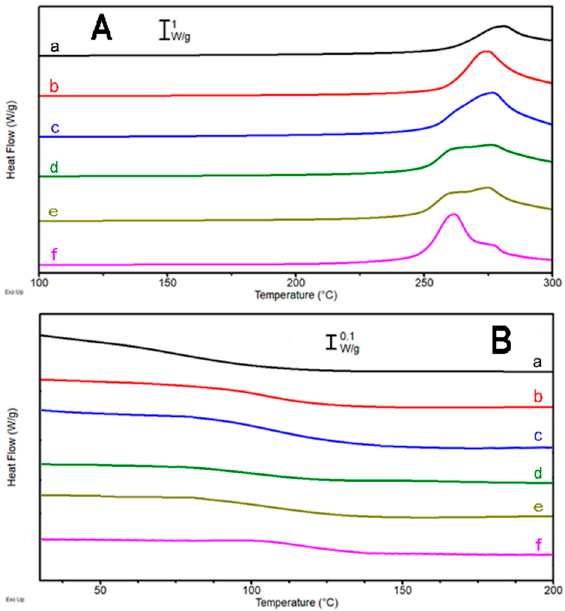
Table 4. Relevant DSC data of DEGBA/guanine (DG) samples.